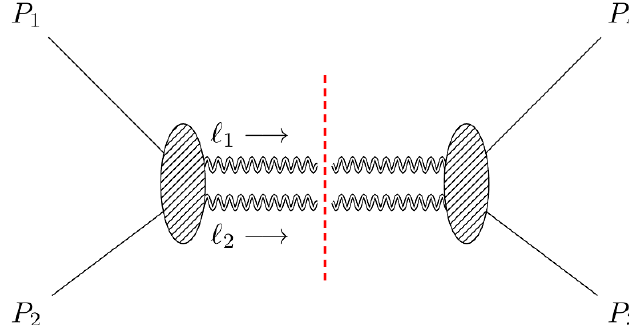
Figure 1 . The kinematic setup, where particles 1 and 4 are incoming and 2 and 3 outgoing. In the center of mass frame, we consider the exchanged momentum q = P 1 + P 2 = (0 ; q ) (in the all outgoing convention) and P 1 = ( E A ; q = 2), P 2 = (cid:0) ( E A ; (cid:0) q = 2) with E A = P 4 are de(cid:12)ned similarly with A $ B .